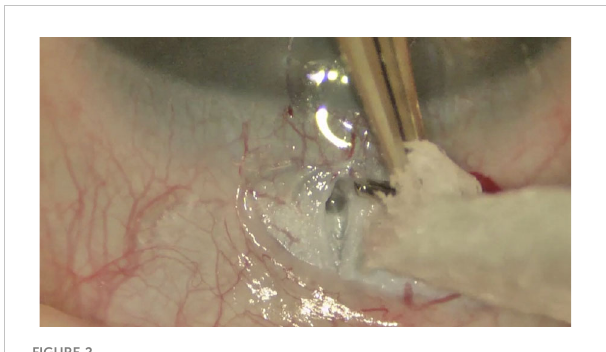
FIGURE 3 Introduction of the Harms trabeculotome probe into the Schlemm ’ s canal and and its rotation toward the anterior chamber.